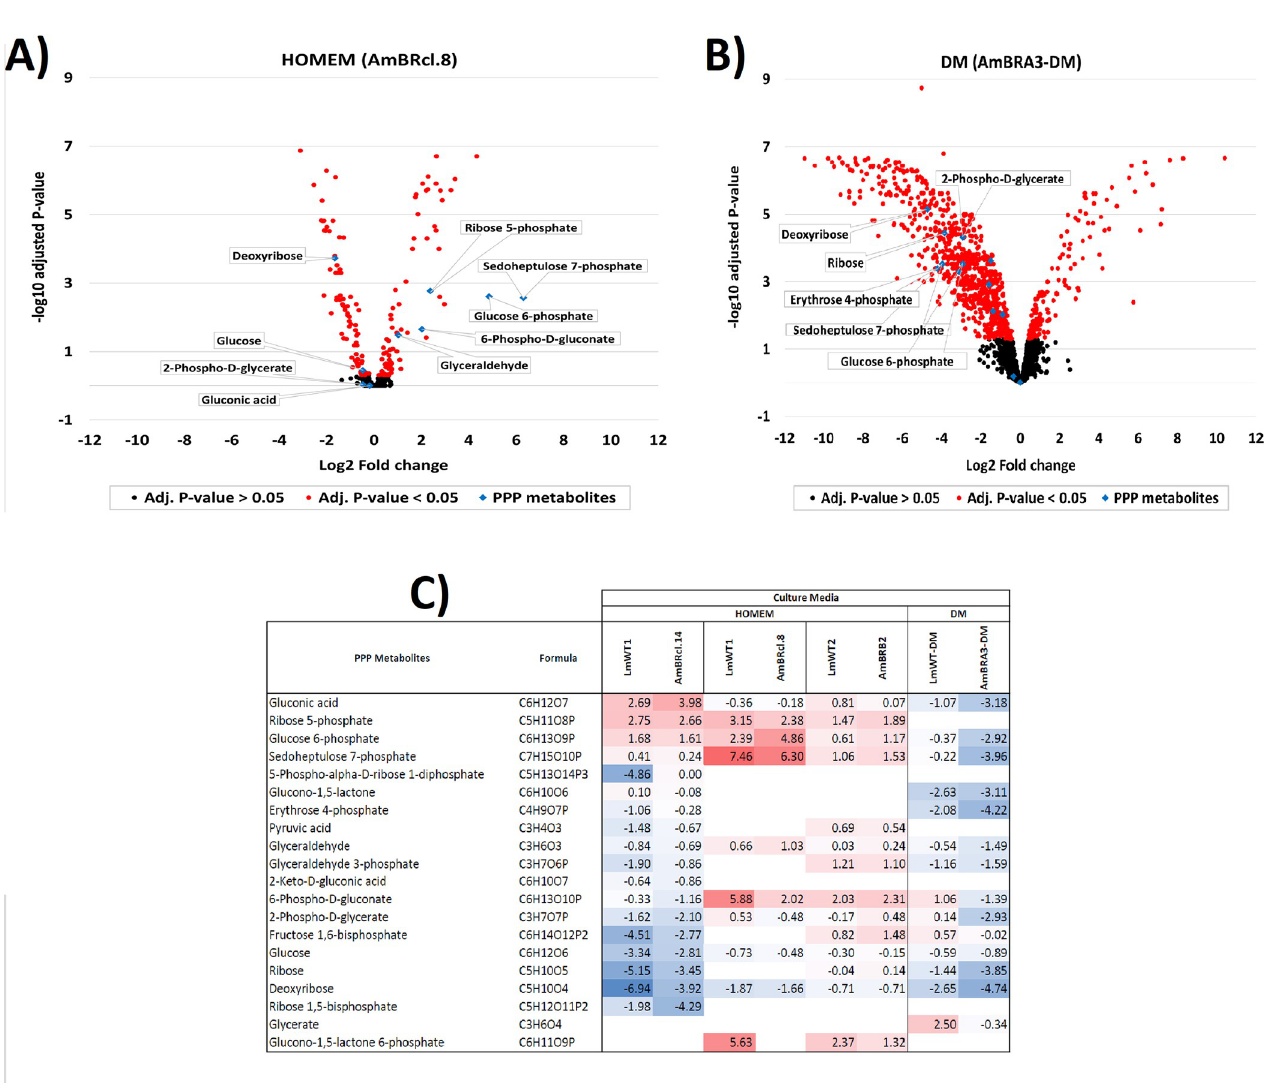
Fig 2. Metabolic effects of exposure to AmB in L . mexicana promastigotes cultured in HOMEM and DM. Mid log AmBR lines alongside with their parental wild-type L . mexicana promastigotes (1 x 10 8 ) were cultured in HOMEM (LmWT1, AmBRcl.14, AmBRcl.8, LmWT2 and AmBR2) and DM (LmWT-DM and AmBRA3-DM). Fig 2A) Volcano plot showing significant log2 fold-changes (red dots) of peaks as detected by LC-MS in promastigotes cultured in HOMEM (AmBRcl.8) and Fig 2B) in DM (AmBRA3-DM). Multivariate data analysis was performed with the PiMP analysis pipeline [115] and the Benjamini-Hochberg procedure adjusted raw P-values (q-values) < 0.05 for ANOVA. Fig 2C) Heat map of representative intermediates of the PPP. Each line represents one biological replicate (n = 4). Increase (red) or decrease (blue) in fold-change is relative to untreated cells after treatment with AmB at 5 x their EC 50 values for 15 mins. Values in bold indicate metabolites identified and all others are putative based on mass. Empty boxes (no value) indicate that the metabolite was not detected. A full list of P-values of the metabolome (including PPP intermediates) is provided in S4 Table.